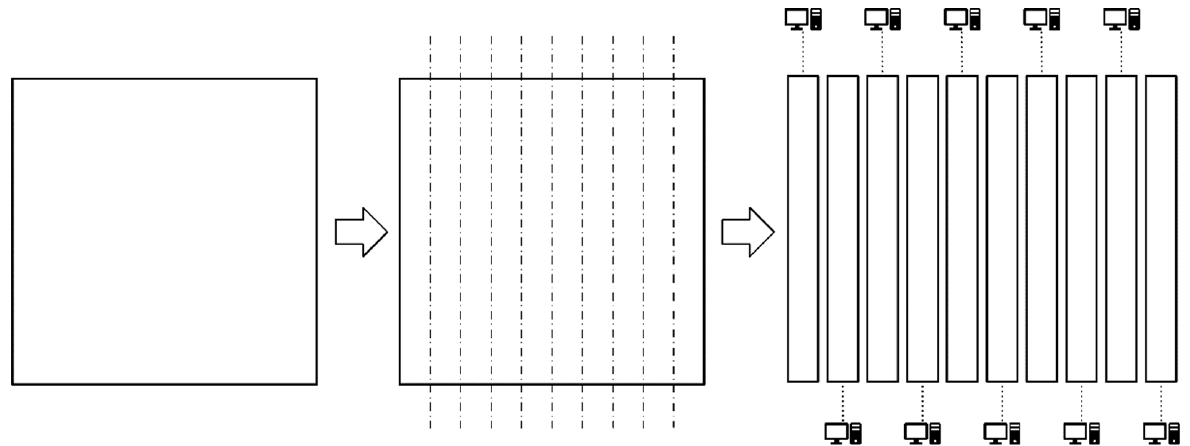
Figure 6. Parallel division strategy for two-dimensional grids (one-dimensional parallel meshing strategy).